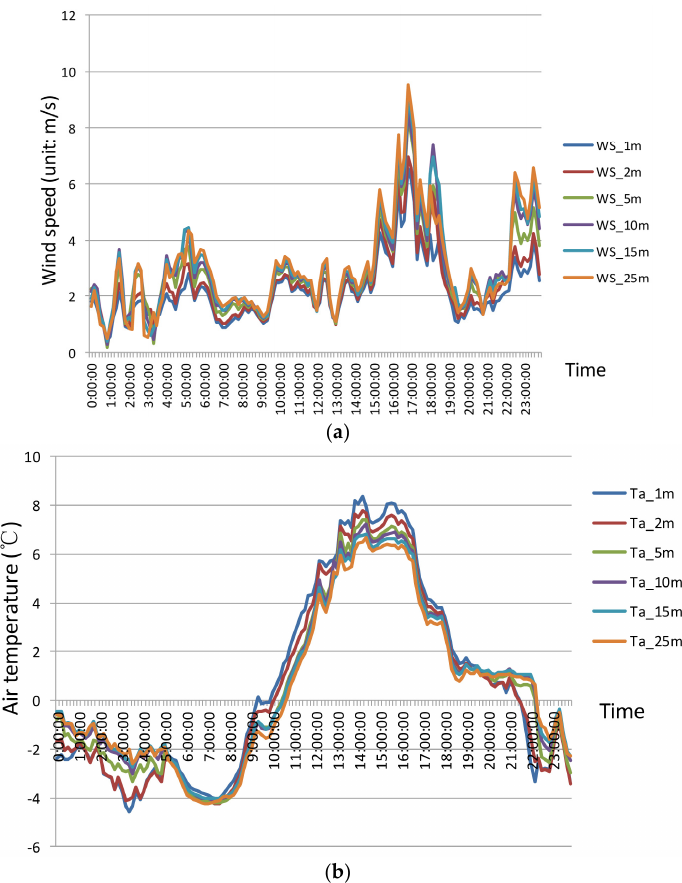
Figure 2. Original observed wind speed ( a ) and air temperature ( b ) at heights of 1 m, 2 m, 5 m, 10 m, 15 m, and 25 m.